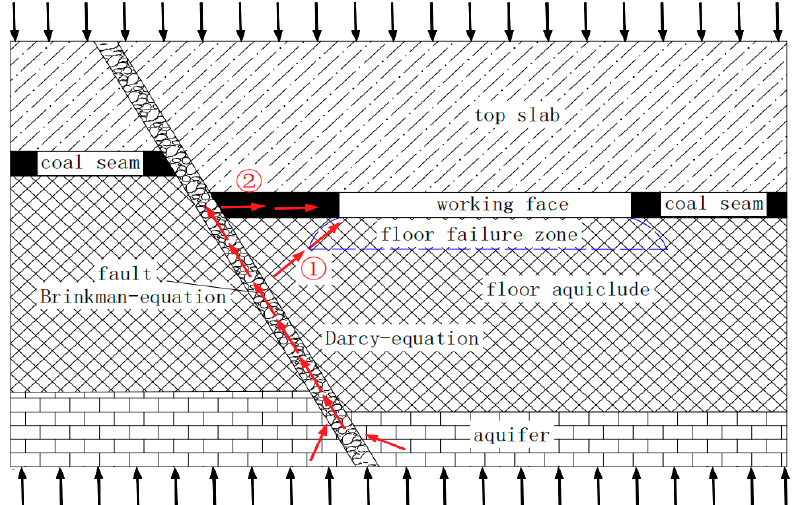
Figure 2. Water inrush path diagram containing fault floor. When the coal seam is not excavated, it is in the original rock stress state, and the original stope stress balance is not affected by external forces; when the coal seam is excavated, the original rock stress state is broken due to the influence of mining, the stress of the stope is redistributed, and the stress at different working face positions is also different. According to the theory of mine pressure control and the theory of the “lower three zones” [17,18], in the process of coal mining, the floor strata in front of the working face are compressed under the action of advanced abutment pressure, and the complete floor strata undergo shear slip deformation. After coal seam mining, due to the failure of the roof strata of the working face to fall in time, the advance support pressure of the floor